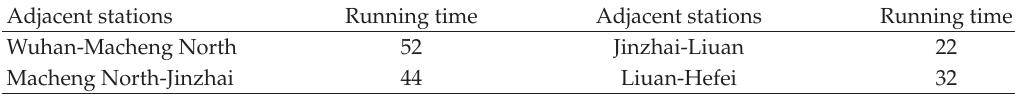
Table 1: The running time between two adjacent stations (cid:6) min (cid:7)